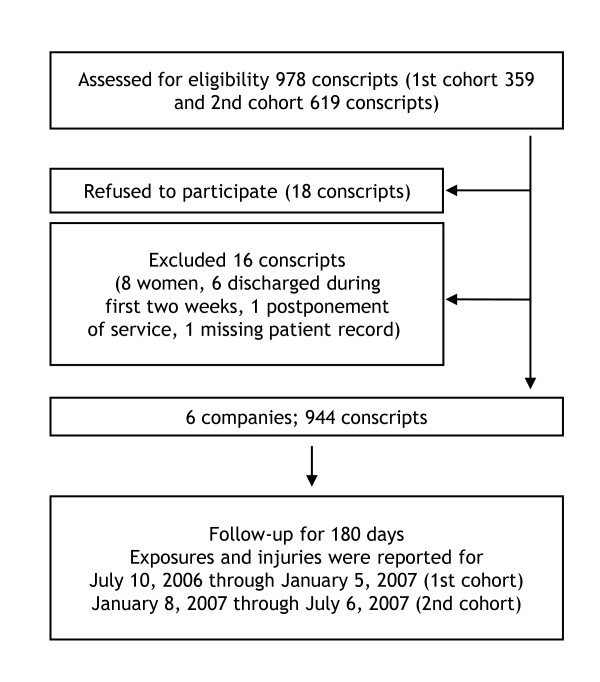
Flow of conscripts through study.